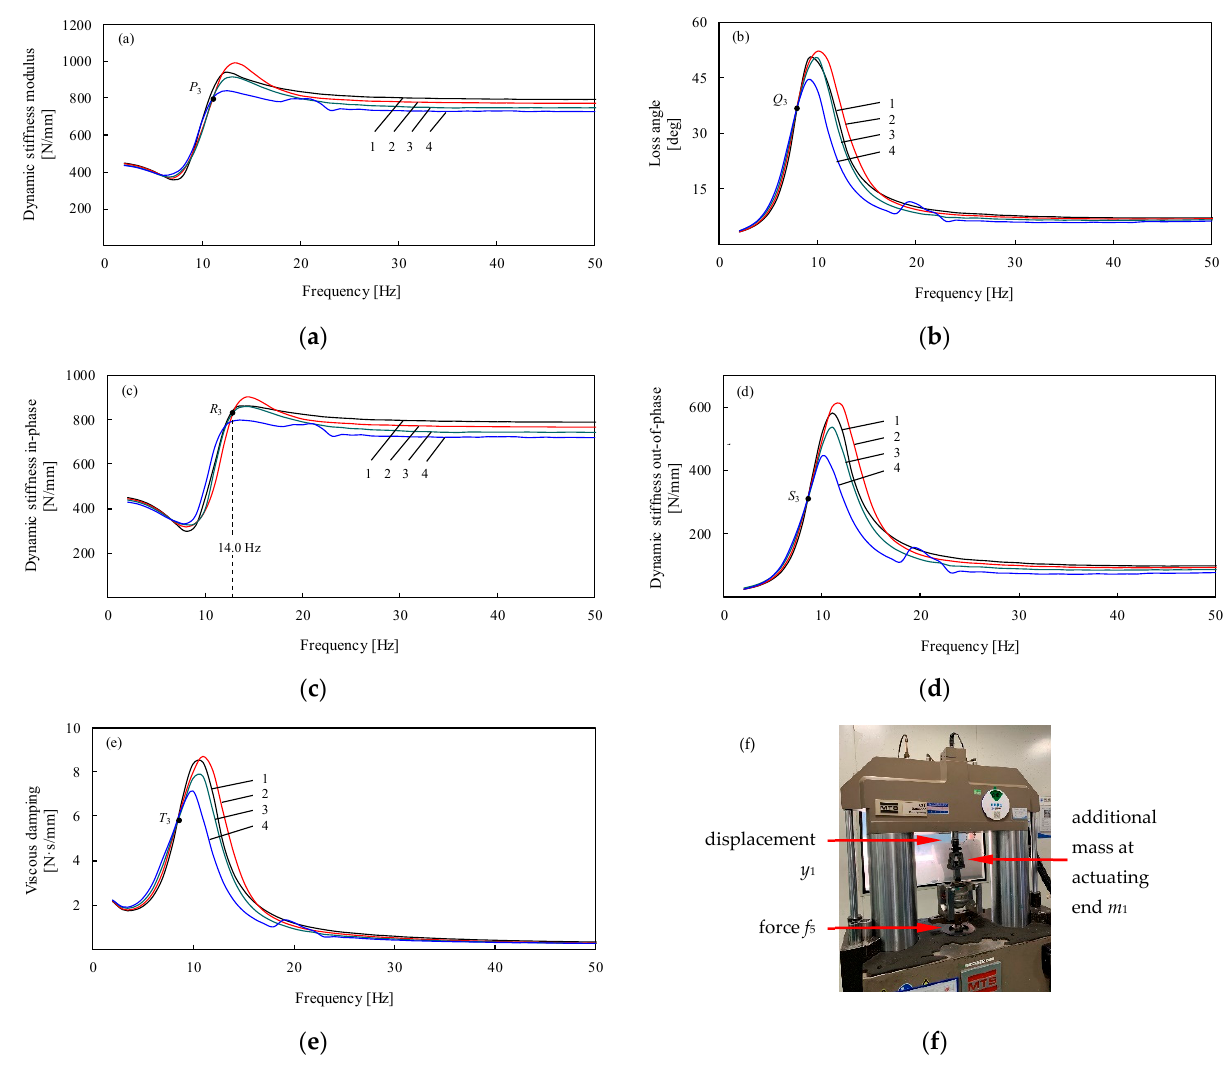
Figure 5. Experimental validation of the passive dynamic properties in mid-low-frequency bands and the fixed points P 3 , Q 3 , R 3 , S 3 , and T 3 of an AHM-IT-DM-OCA. ( a ) Dynamic stiffness modulus; ( b ) loss angle; ( c ) dynamic stiffness in-phase; ( d ) dynamic stiffness out-of-phase; ( e ) viscous damping; ( f ) test rig. Key : The numbers 1–4 correspond to excitation amplitudes of Y 1 = 0.4, 0.6, 0.8, and 1.0 mm, respectively.